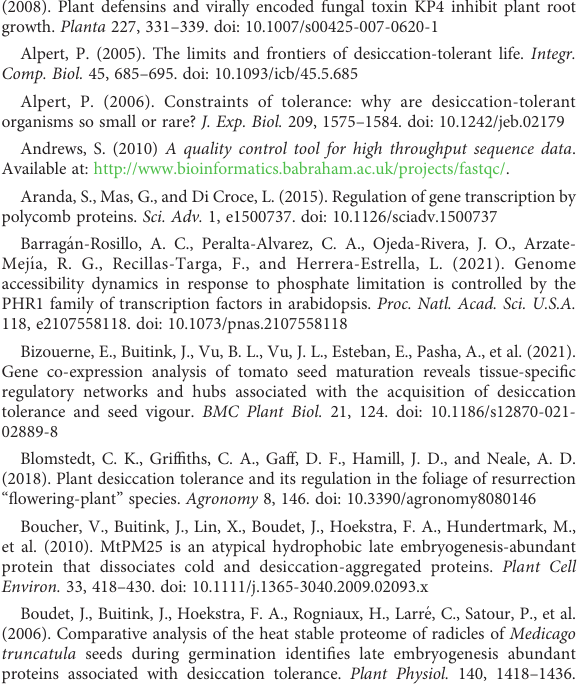
SUPPLEMENTARY FIGURE 1 Genes from cluster 5 whose expressions were negatively correlated with